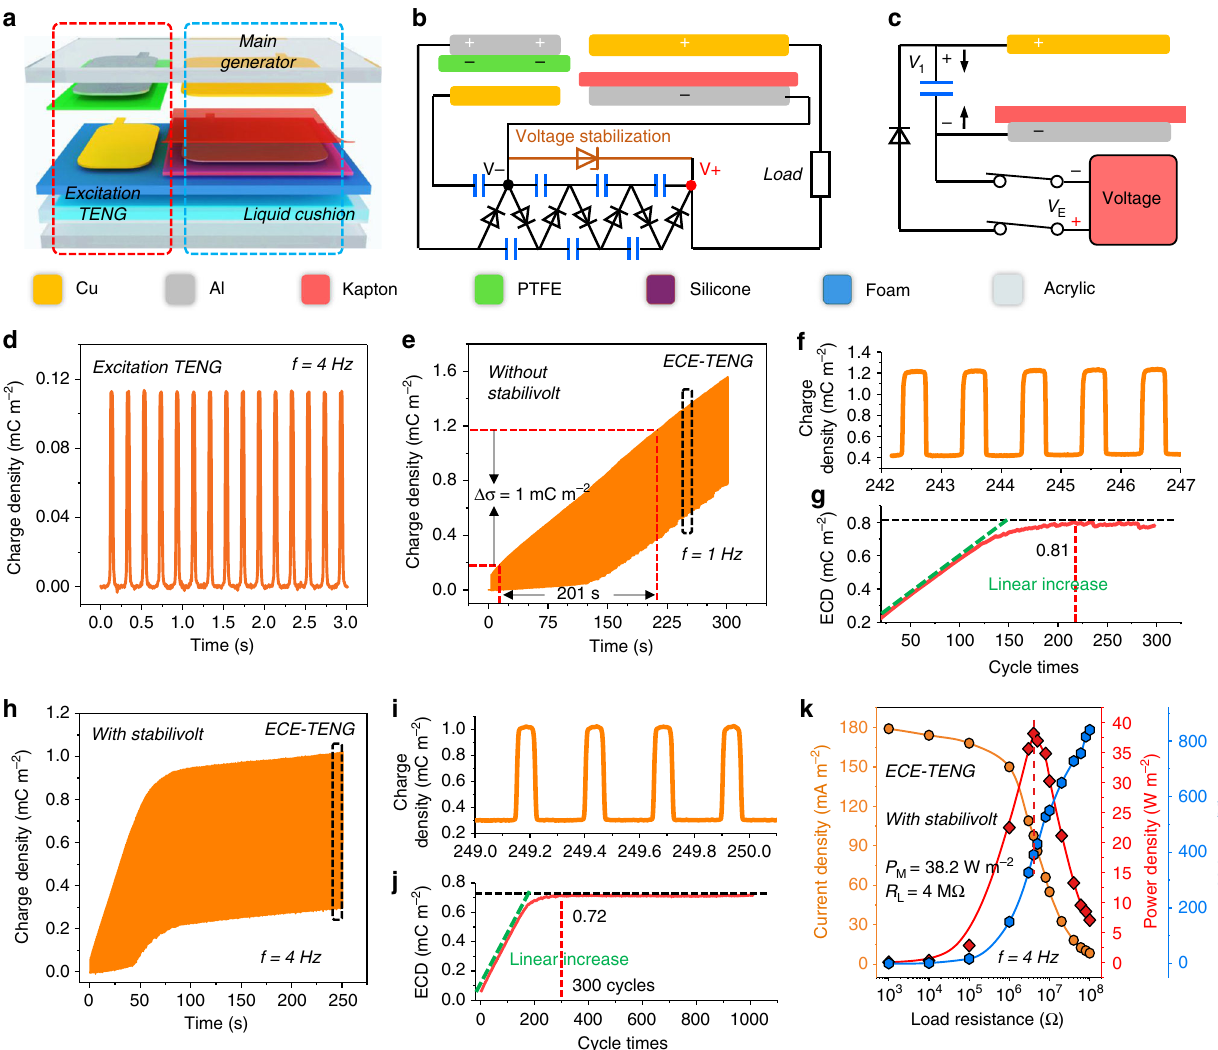
Fig. 2 Mechanism and output of external charge excitation nanogenerator. a Structural illustration of ECE-TENG. b The systematical electric circuit of ECE- TENG. c Simpli fi ed working components of ECE-TENG. d The basic output charge of the excitation TENG under 4 Hz operation frequency. e The dynamic output charge accumulation process of ECE-TENG without voltage stabilization element under 1 Hz operation frequency. f The detailed output charge curve from the dashed area. g The effective charge density (ECD) versus operation cycles. h The dynamic output charge accumulation process of ECE-TENG with voltage stabilization element under 4 Hz operation frequency. i The detailed output charge curve from the dashed area. j The ECD versus operation cycles. k The current, voltage and power output of ECE-TENG with voltage stabilization under various external load (sinusoidal motion with 4 Hz frequency). The thickness of the dielectric Kapton fi lm here is 9 μ m. The effective charge output density is calculated from main TENG